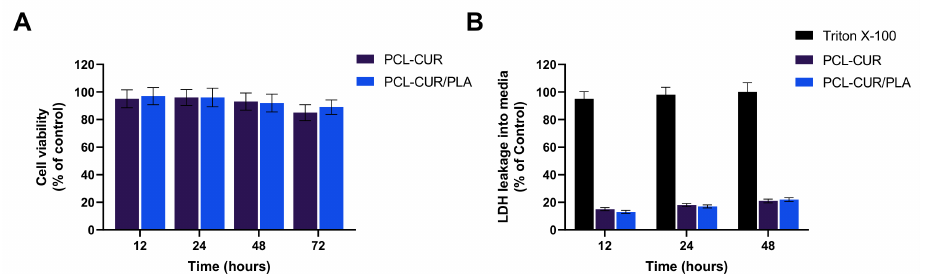
Figure 9. Cytotoxicity of curcumin released from Cur loading membranes tested via CCK-8 ( A ) and LDH ( B ) assays after 12, 24, 48, and 72 h of incubation. For each sample, six different experiments were conducted, and the results were expressed as the mean of the values obtained (mean ±